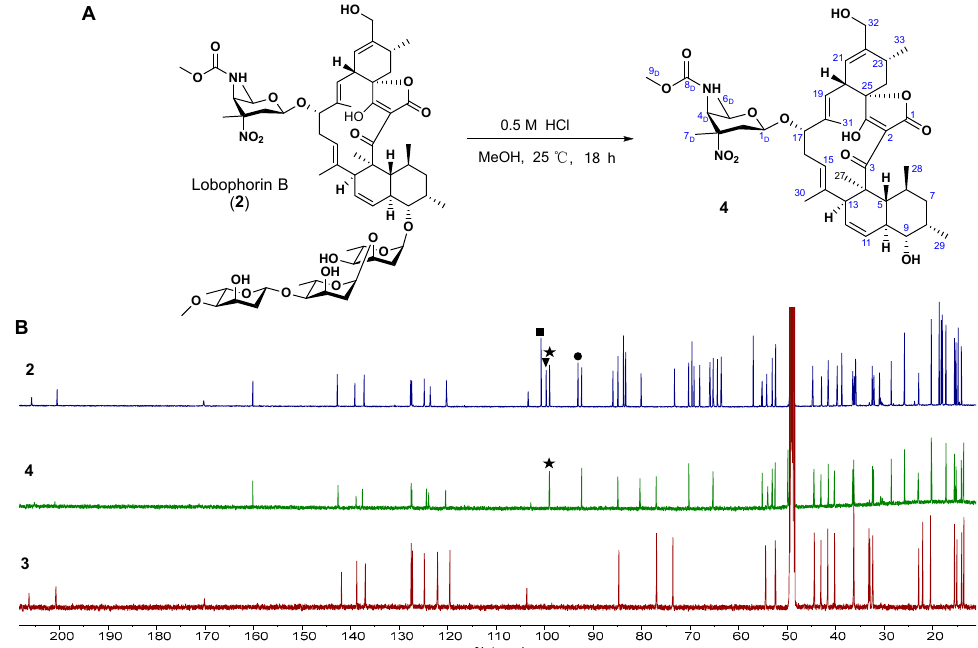
Figure 3. Generation of 4 from LOB B ( 2 ). ( A ) The hydrolysis of 2 in 0.5 M-methanolic HCl. ( B ) The comparison of 13 C NMR spectra of 4 to 2 and 3 in CD 3 OD. : The carbon signal ( δ C = 100.7 ppm) from sugar C; (cid:72) : The carbon signal ( δ C = 99.7 ppm) from sugar A; (cid:70) : The carbon signal ( δ C = 99.0 ppm) from D-kijanose; and : The carbon signal ( δ C = 93.1 ppm) from sugar B.